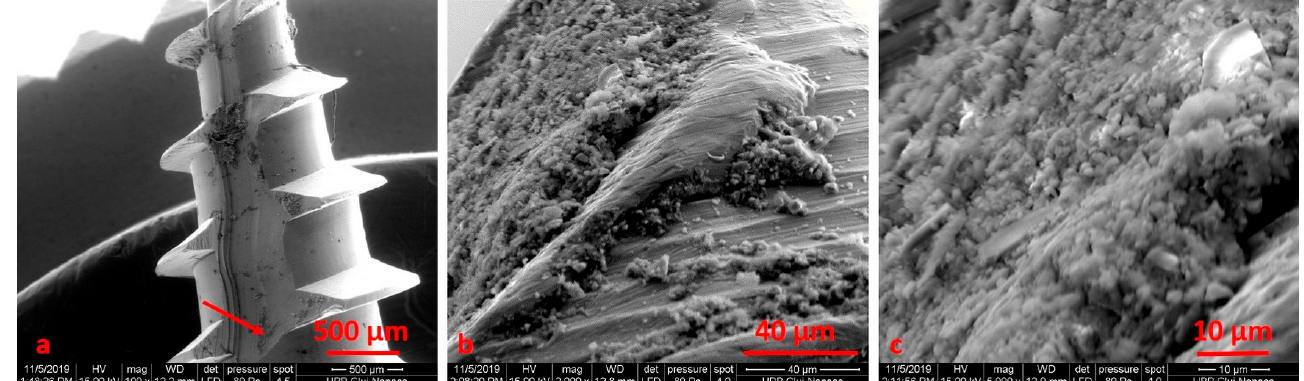
Figure 9. SEM images of sterilized mini-implants, recovered from patients, at ×100 ( a ), ×2000 ( b ), ×5000 ( c ) magnification (cracks).